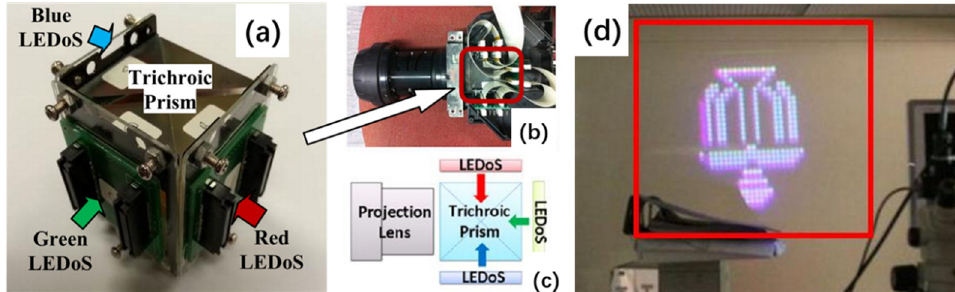
Figure 13. ( a ) Triangular prism projection source with an RGB three-color micro-LED array on silicon (3-LEDoS); ( b ) 3-LEDoS projector prototype and ( c ) schematic diagram of the optical architecture; ( d ) The image projected on the wall by the 3-LEDoS. Reproduced from [87], with permission from Institute of Electrical and Electronics Engineers, 2013.